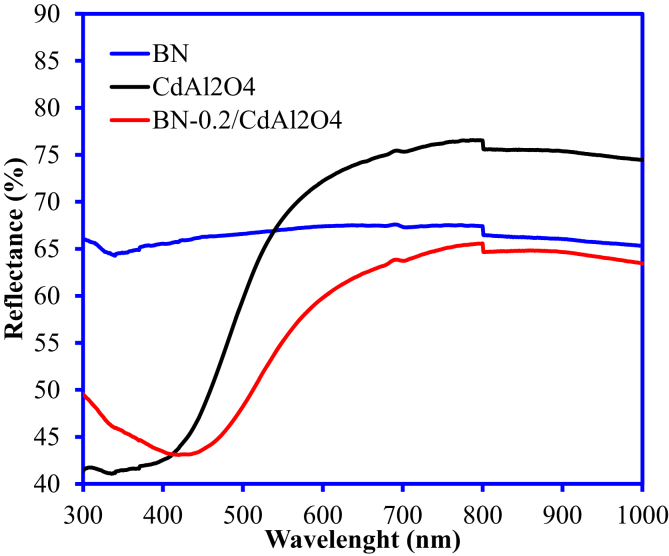
Diffuse reflectance spectra of BN, CdAl2O4 and BN-0.2/CdAl2O4 composite.